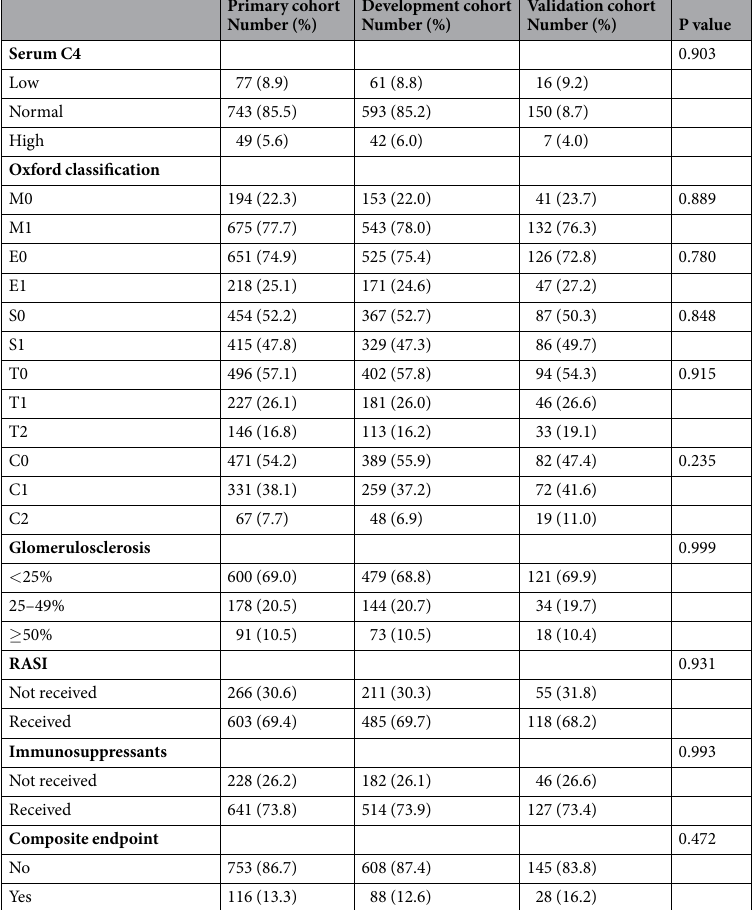
Table 1. Demographic and clinicopathological variables of the primary, development and validation cohorts. UPE, urinary protein excretion; eGFR, estimated glomerular filtration rate; RASI, renin-angiotensin system